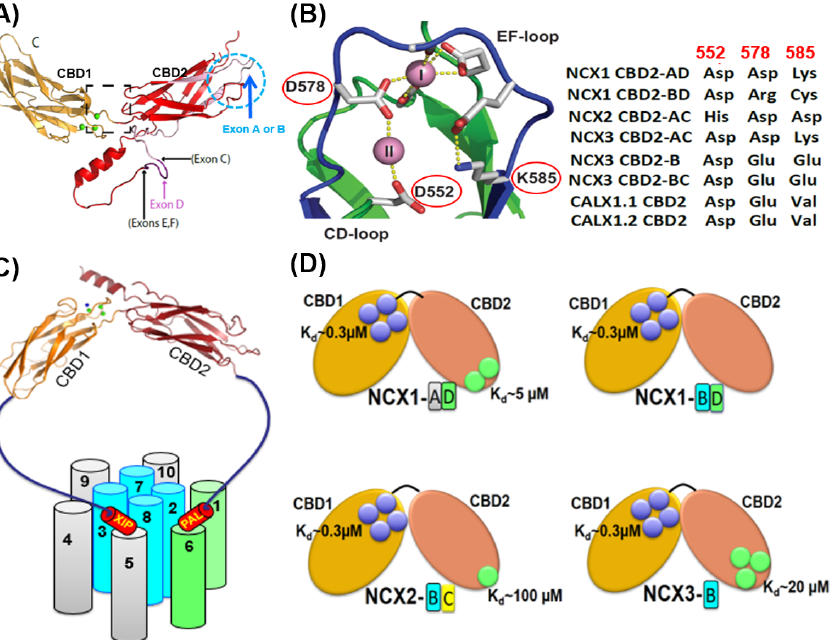
Figure 5. Structural basis of exon-dependent regulatory diversity in eukaryotic NCX variants. ( A ) Experimentally obtained NMR structures of CBD1 (2FWS), CBD2-AD (2FWU), and CBD2-BD (2KLT) of NCX1 were superimposed on the template of NCX1-CBD12 crystal structure (PBD 3US9) to demonstrate the structural positions of mutually exclusive (A or B) and cassette (CDEF) exons at CBD2. ( B ) The crystal structure of NCX1-CBD2-AD (PDB 2QVM) shows that K585 forms a salt bridge with D552 and E648 in the absence of Ca 2+ (thereby stabilizing apo-CBD2), whereas in the